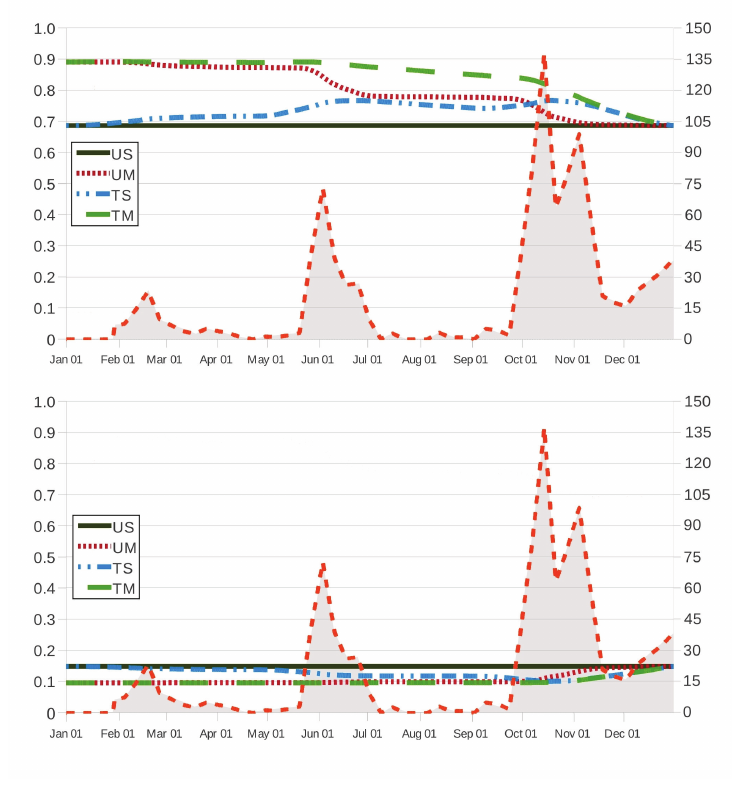
Figure 4. Expected proportions τ − 1 E s ( t 0 ; τ ) ( top ) and τ − 1 C s ( t 0 ; τ ) ( bottom ) versus the intervention age t 0 for τ = 1 year and increments in the number of L 3 infective larvae in the small intestine (shaded area, right vertical axis). Scenario US, and grazing strategies UM, TS and TM with the anthelmintic